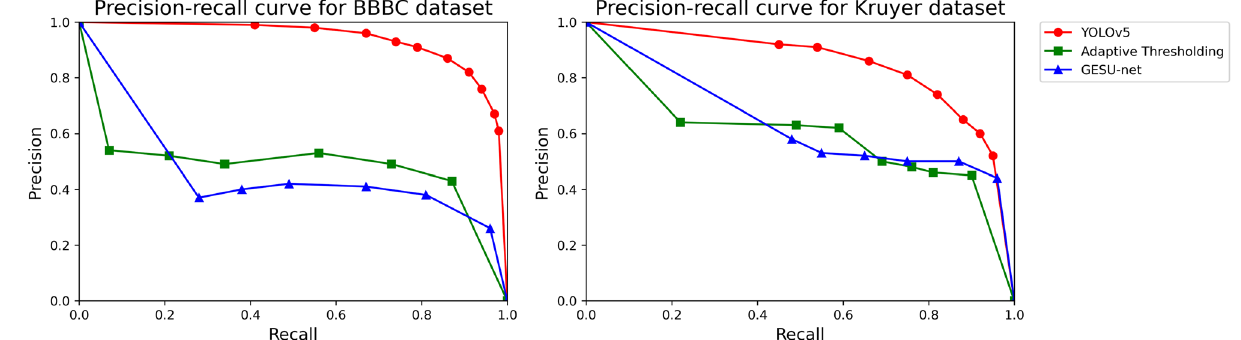
Figure 3. Precision–recall curves. Precision–recall curves demonstrate the astrocyte detection performance of different algorithms on the BBBC (left panel) and Kruyer (right panel) image datasets. Our method based on YOLOv5 is compared against GESU-Net 31 and Adaptive Thresholding implemented using FIJI (see description in the text).